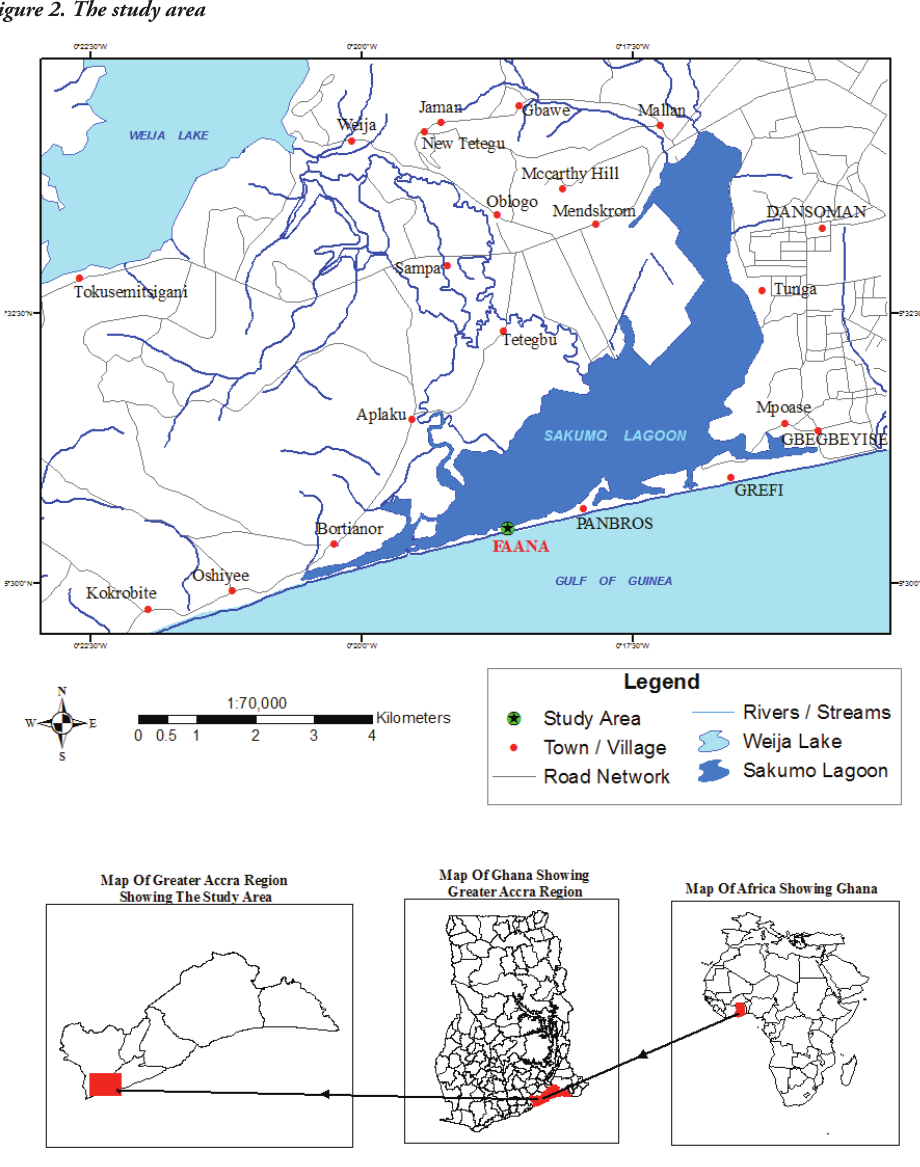
Figure 2. The study